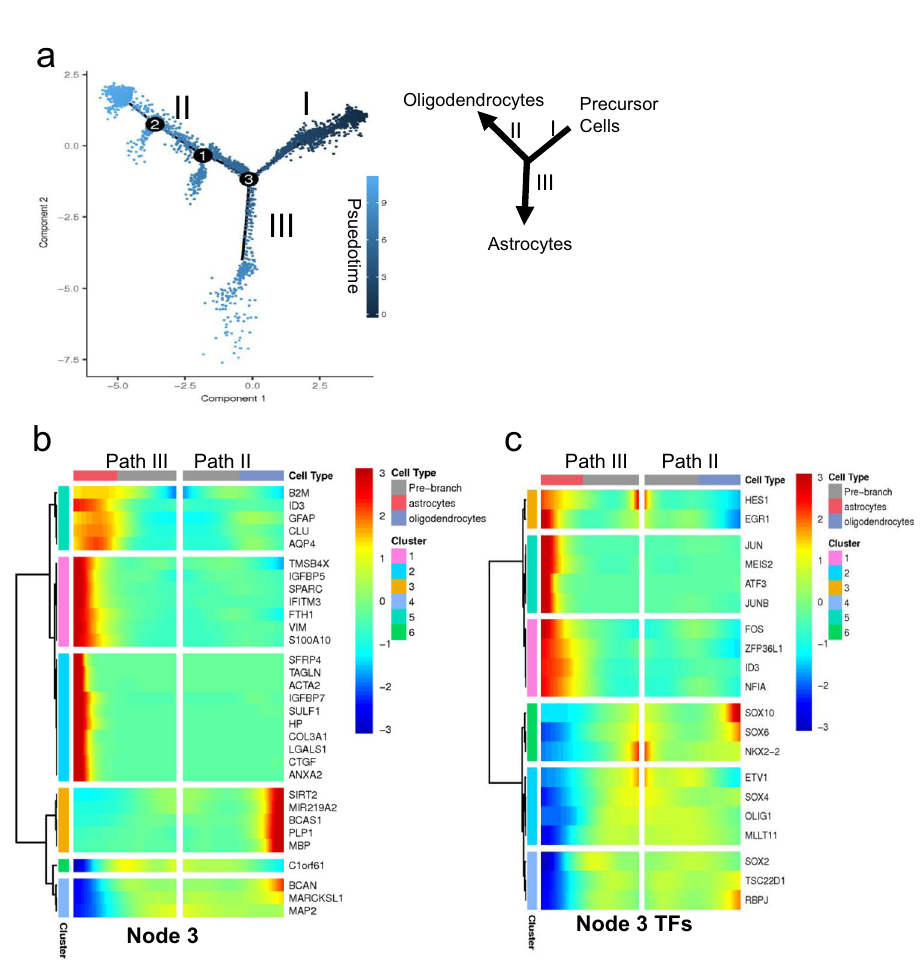
Fig. 8 Pseudotemporal trajectory analysis of the single-cell transcriptomes of the hOPCs. a Developmental trajectories of the puri fi ed reporter OPCs generated, using Monocole-2, demonstrate two prominent paths for the OPCs. Darker colored dots (on Path I) represent developmentally younger cells and the lighter colored dots (on Paths II and III) represent more mature cells. b , c Kinetic heatmap generated using BEAM regression model capturing the most differentially expressed genes ( b ) and transcription factors ( c ) between Paths II (oligodendrocytes) and III (astrocytes). The genes are hierarchically clustered based on their expression pattern. Red color represents upregulation and blue is used for